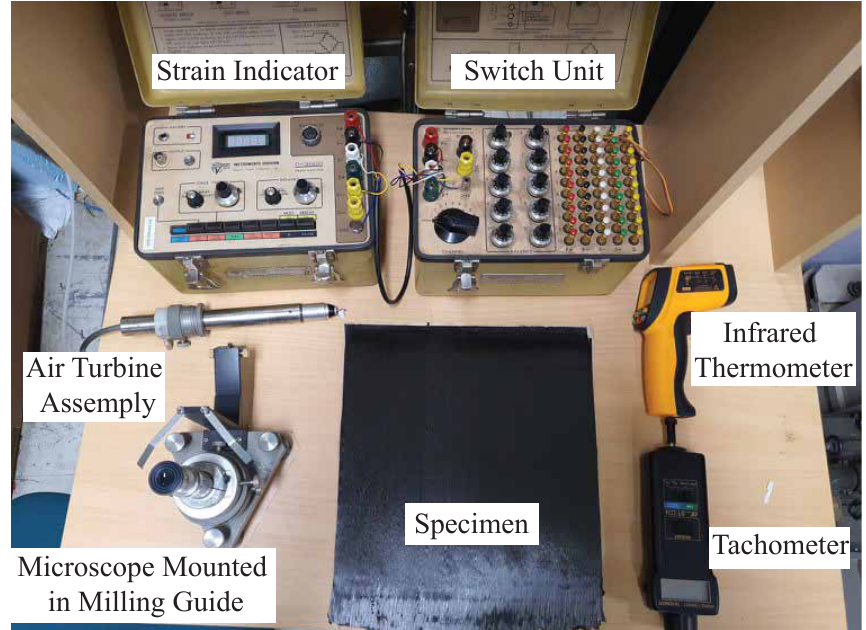
Figure 8. Incremental hole-drilling method (IHDM) equipment.